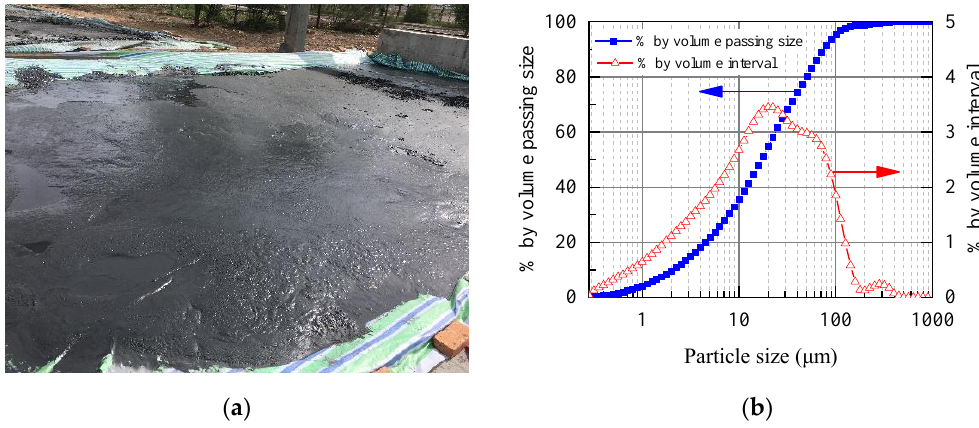
Figure 1. Samples ( a ) and PSD ( b ) [25] of total tailings.